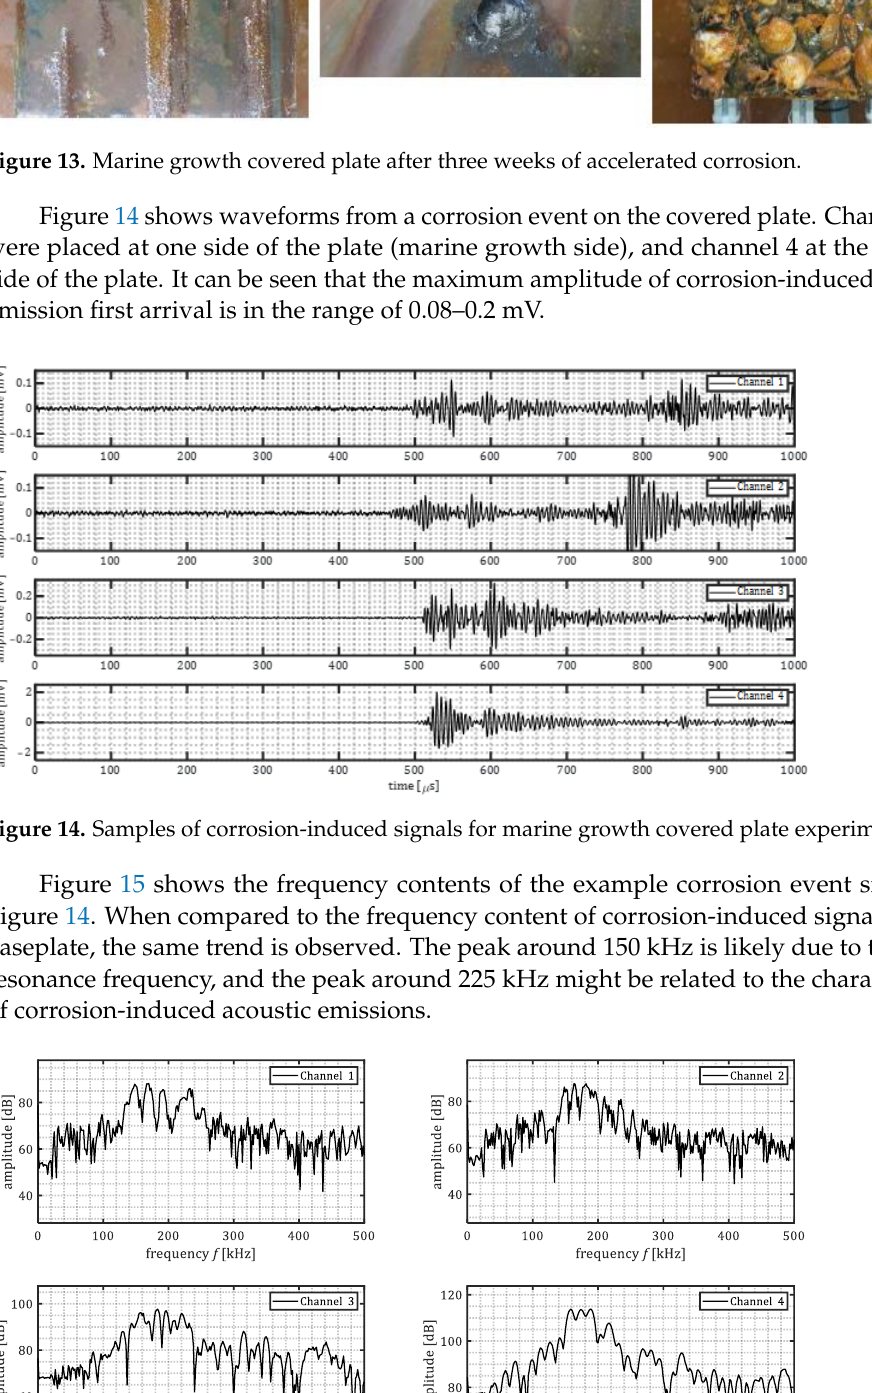
Figure 13. Marine growth covered plate after three weeks of accelerated corrosion.